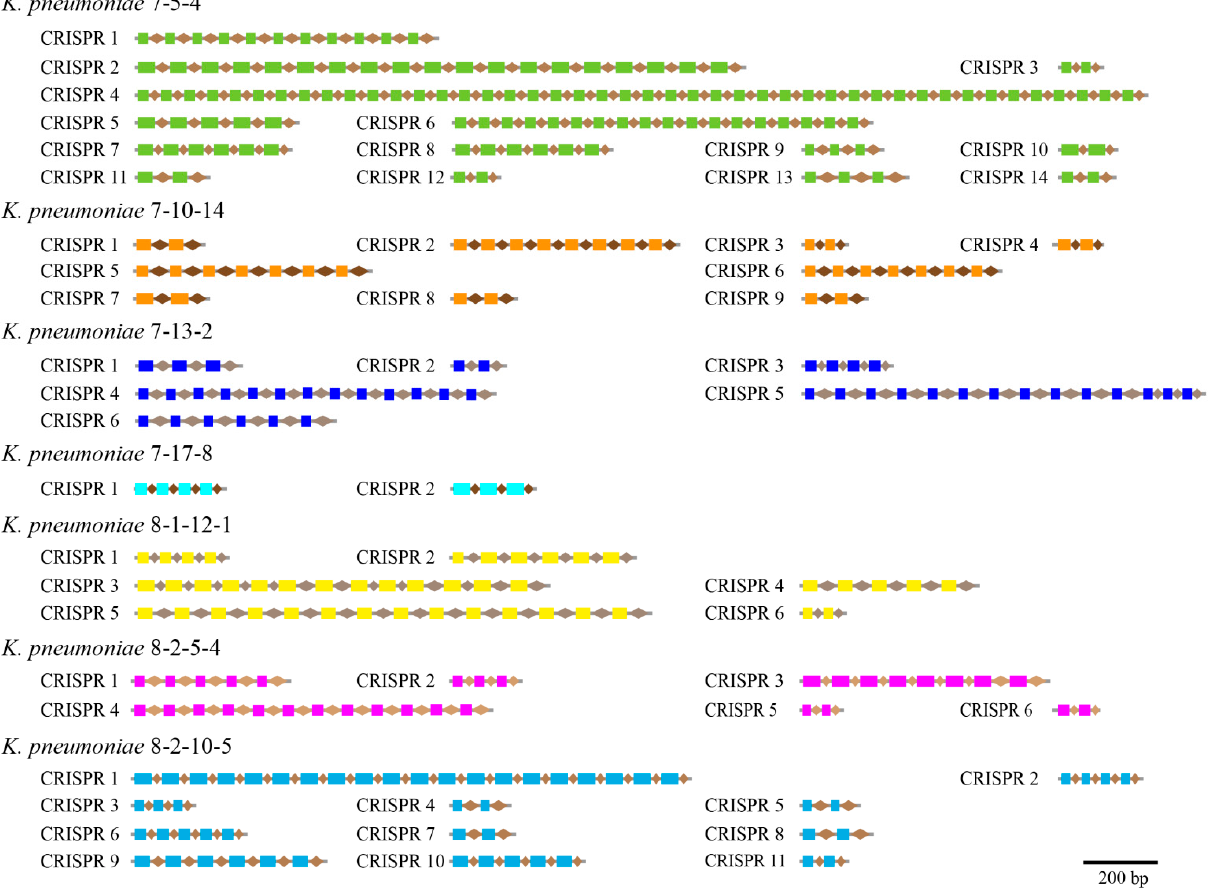
Figure 6. Structural features of the CRISPR repeats identified in the K. pneumoniae genomes. The repeat sequences were shown by the rectangle in different colors, and the spacer regions were represented by rhombuses in different colors.